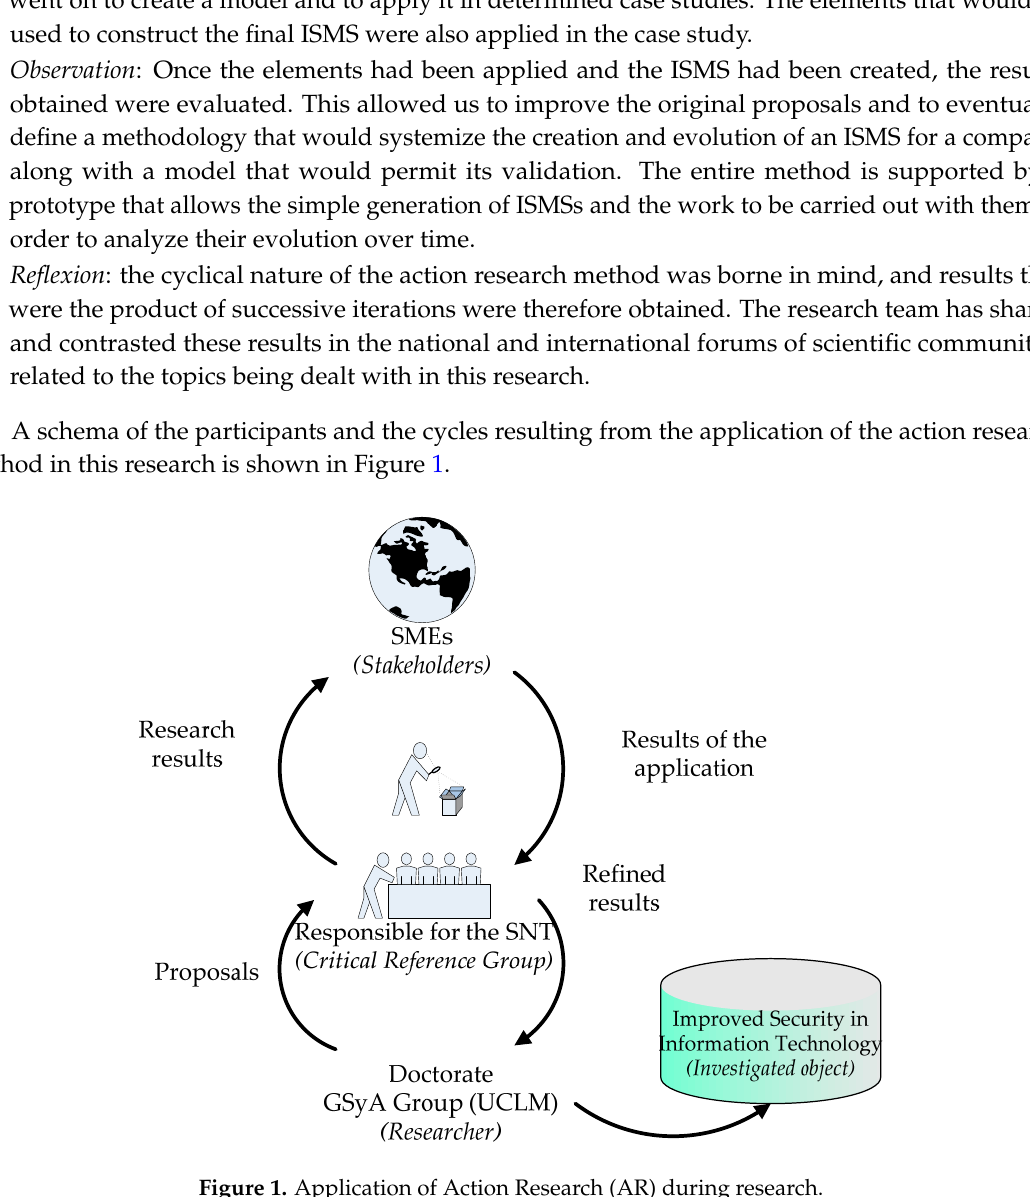
Figure 1. Application of Action Research (AR) during research.